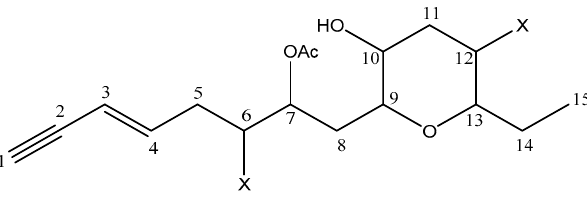
Figure 1. Planar structure for sagonenyne ( 20 ); X = halogen atom. Pls provide a clearer picture.